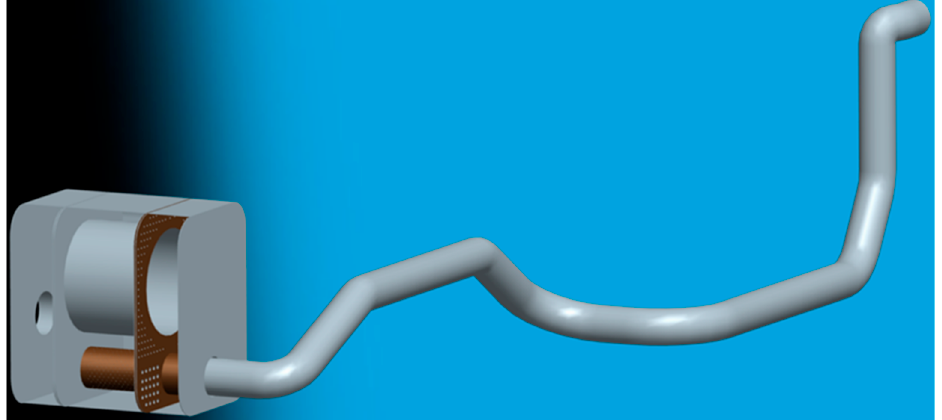
Figure 3. The full-scale geometric model of the SCR system.